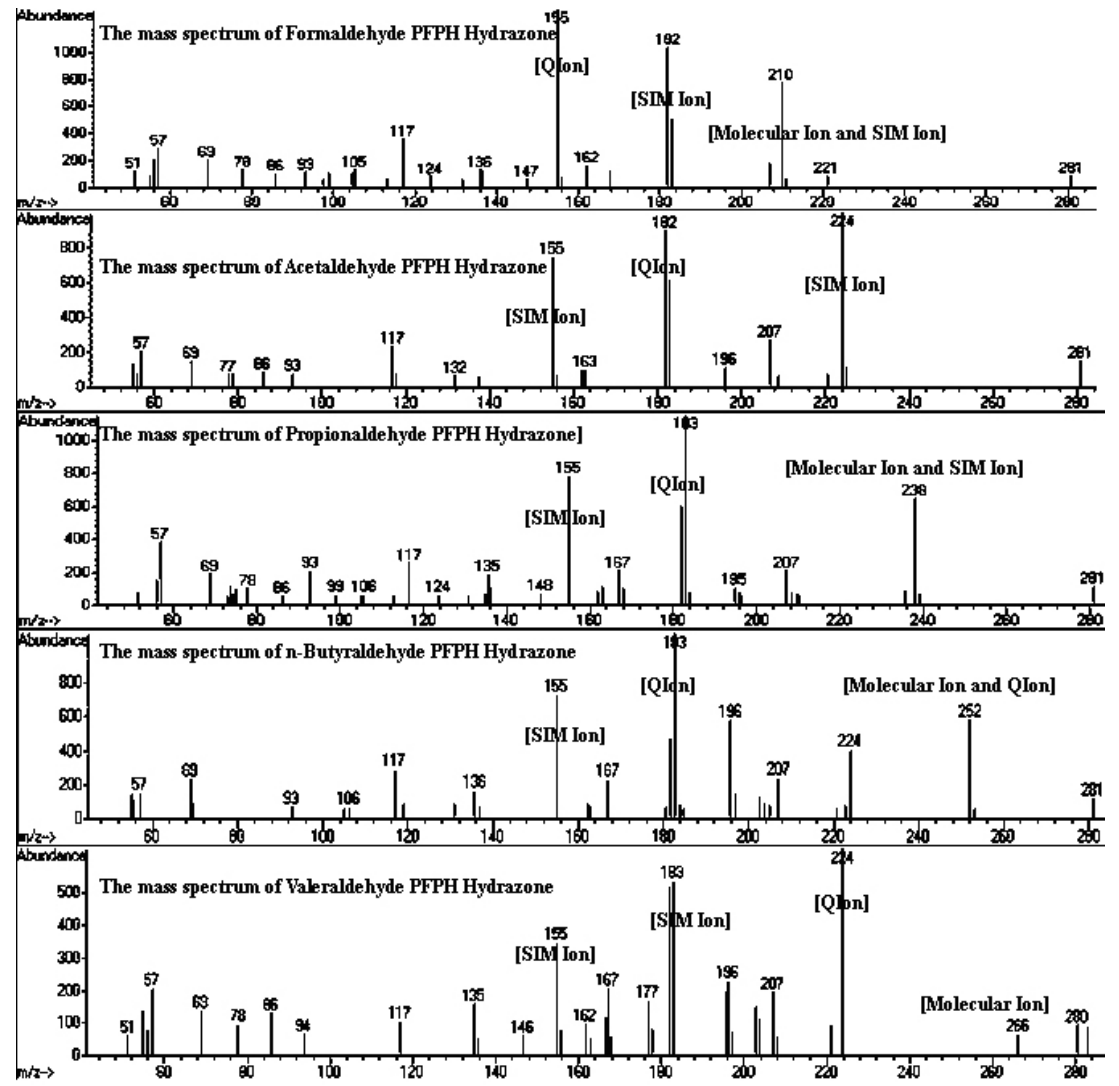
Figure 3. The mass spectrum of the PFPH-hydrazone derivatives of formaldehyde, acetaldehyde, propionaldehyde, n-butyraldehyde, and valeraldehyde. SIM Ion: selective ion monitoring ion; Qion: quantification ion.